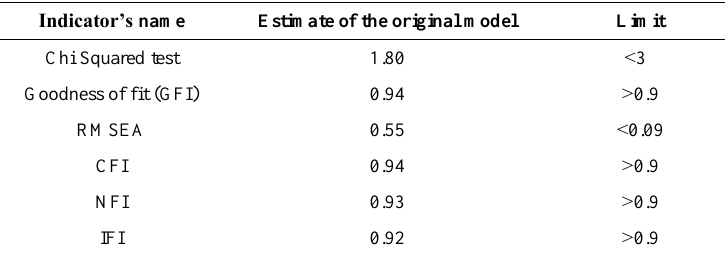
Table 1. Interpretation of structural equation model